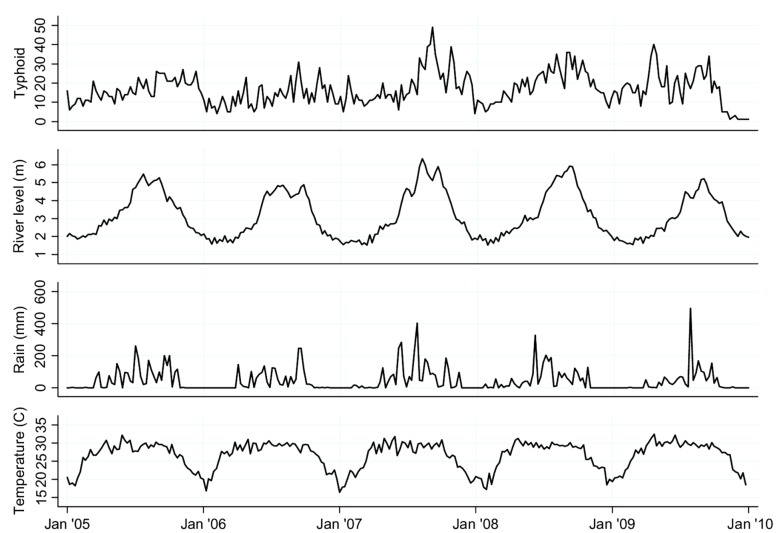
Seasonal variations in Typhoid cases.The number of Typhoid cases per week, with reference to river level, temperature and rainfall data in Dhaka Metropolitan Area, 2005–2009.